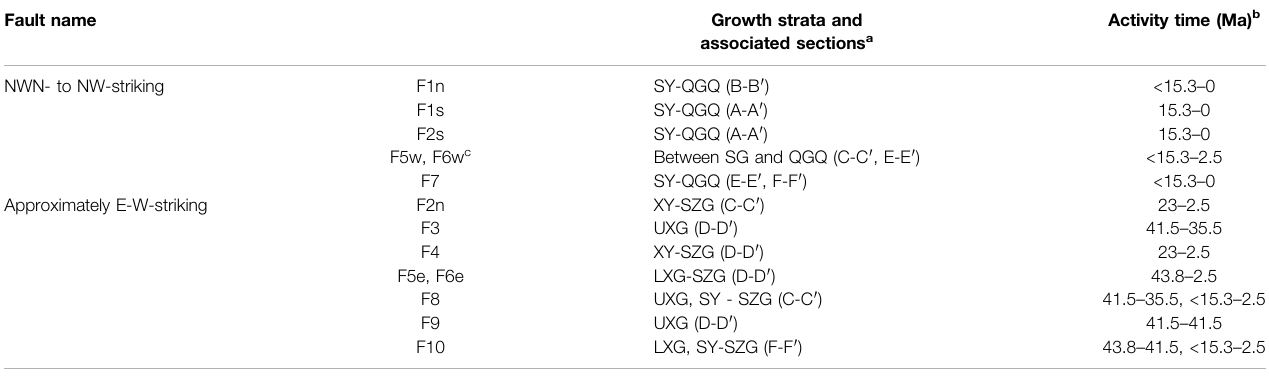
TABLE 2 | Summary of growth strata and activity time of faults in the study